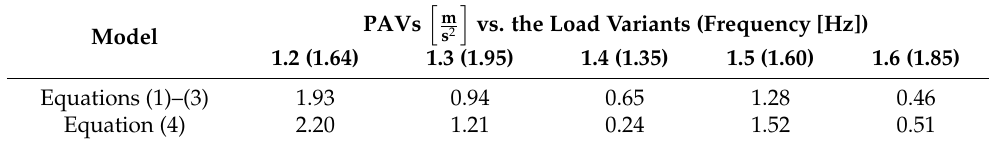
Table 16. The EN 1990:2002+A1 [37] and BS EN 1991-2:2003 [43] comfort criteria assessments.